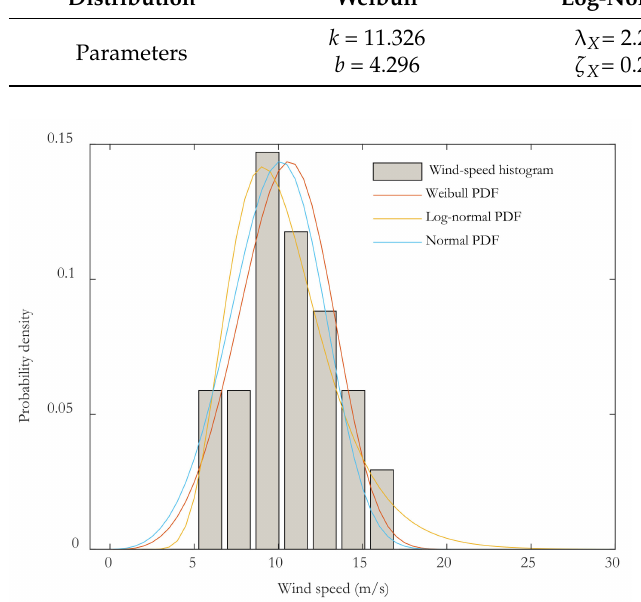
Figure 7. PDF comparison of all